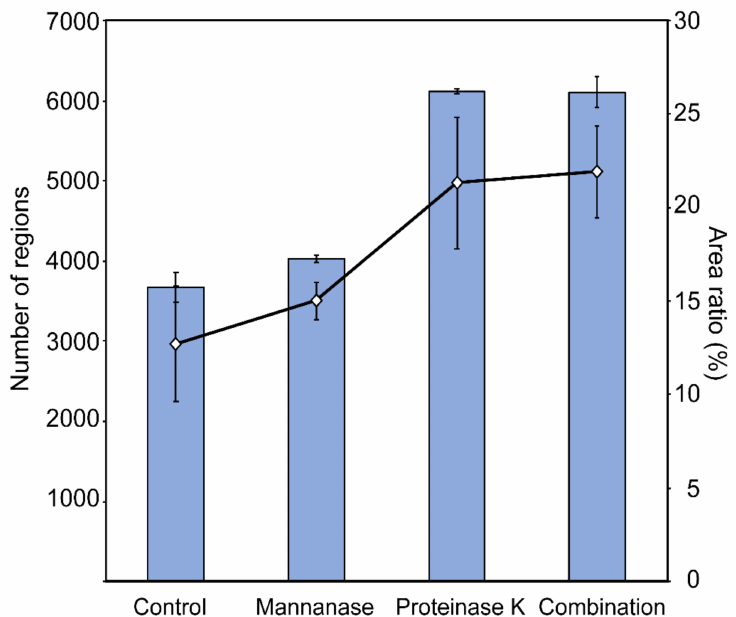
Figure 9. Quantification of the total dent area on the cell surface. The surface images in Figure 8 were converted to black-and-white binary. The number of black areas with an area of 100 pixels or more (bar chart) was counted, and the percentage of the area it occupies (line chart) was also calculated. The increase in the black area indicates an increase in the dent area on the cell surface. Data are expressed as the mean ± standard deviation (n =